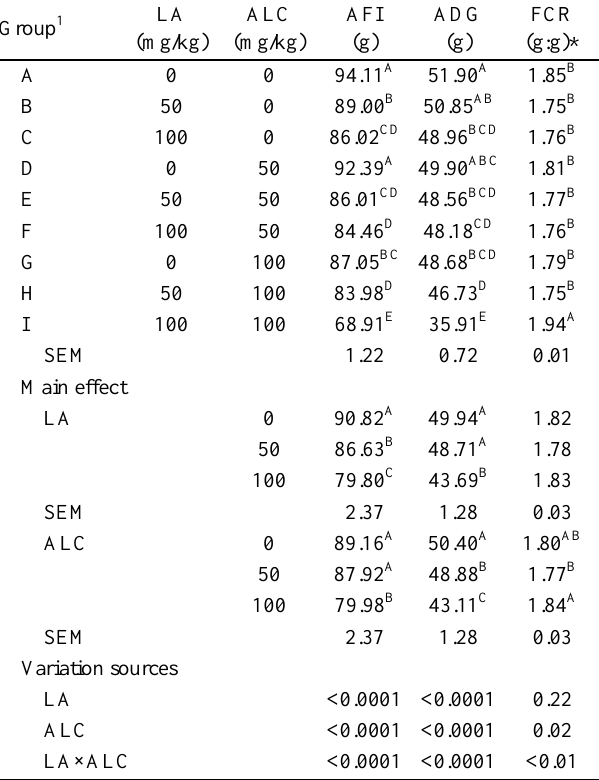
Table 2. Effects of dietary LA and ALC on the growth performance of